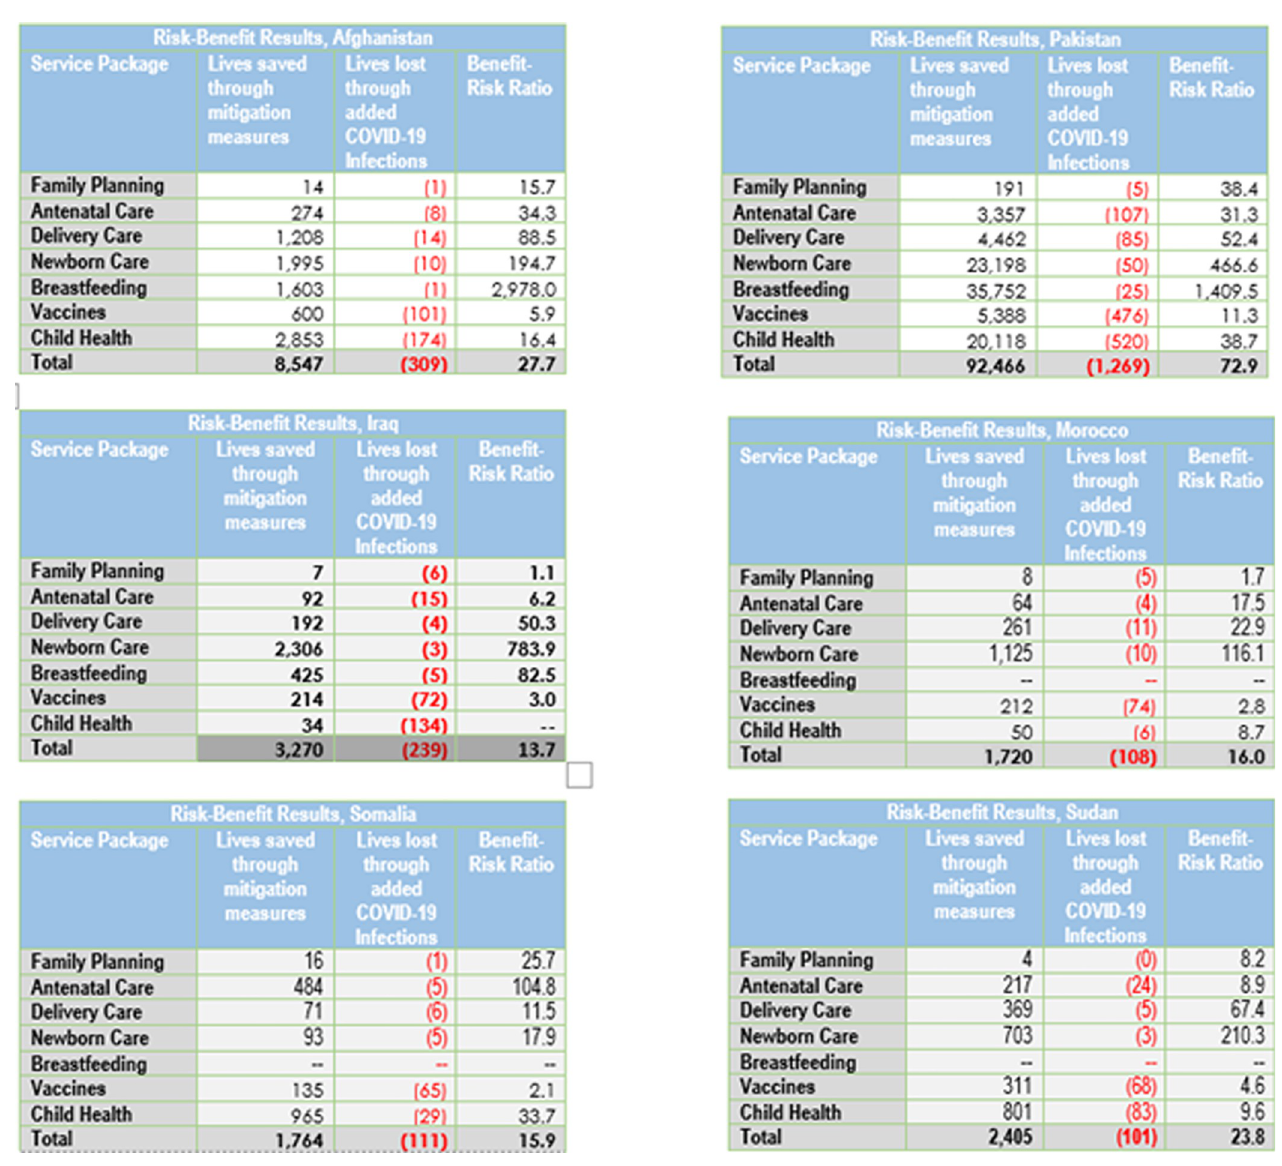
Fig 3. Estimated lives saved as a result of mitigation measures and restored coverage of RMNCH services and benefit-risk ratios, by country for 2020.